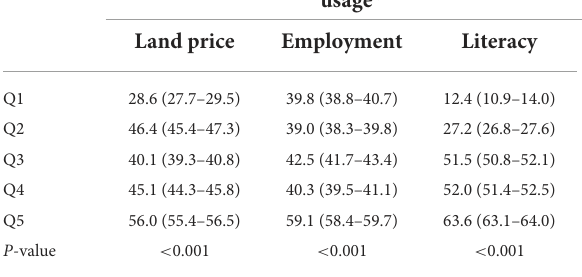
TABLE 3 Comparison of the adjusted prevalence rates of face mask-wearing among quintiles of the socioeconomic factors, using Analysis of Covariance